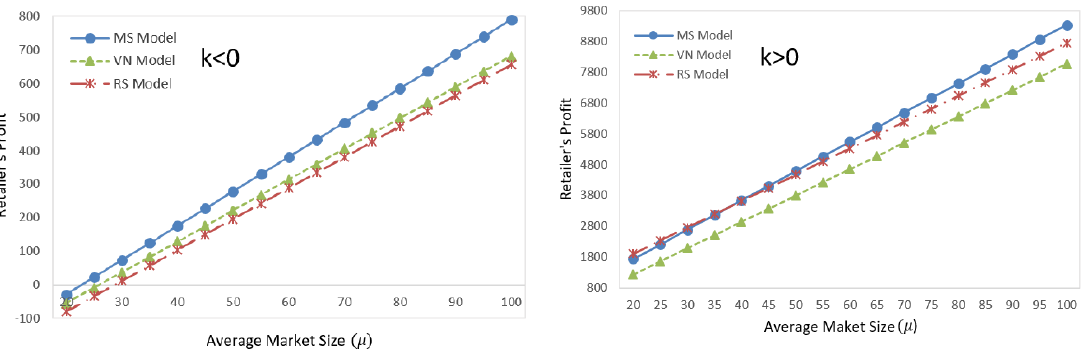
Figure 1. Retailer’s profit when the service level is ( left ) low and ( right )